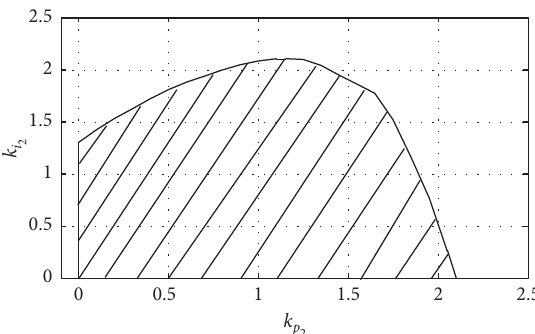
Figure 24: Value range of control parameters k